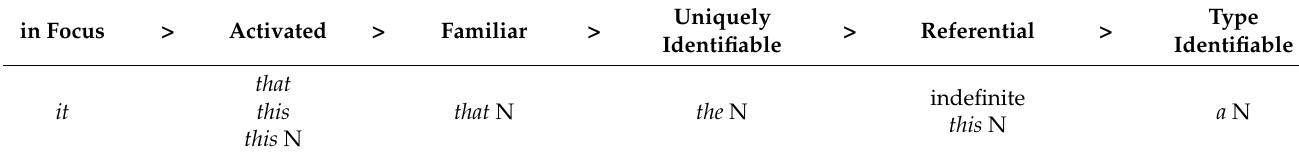
Table 1. The Givenness Hierarchy (Gundel et al.